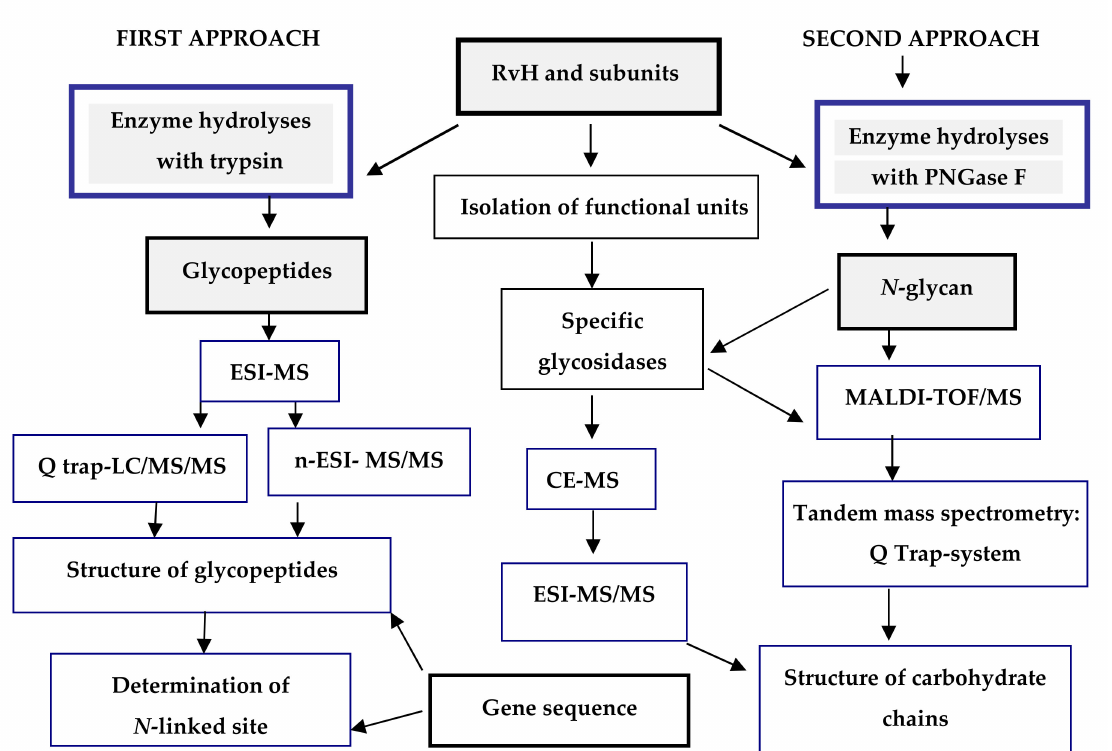
Figure 3. Scheme for analysis and determination of the carbohydrate structure of RvH1, RvH2 and FUs. On the basis of this strategy, two main approaches are